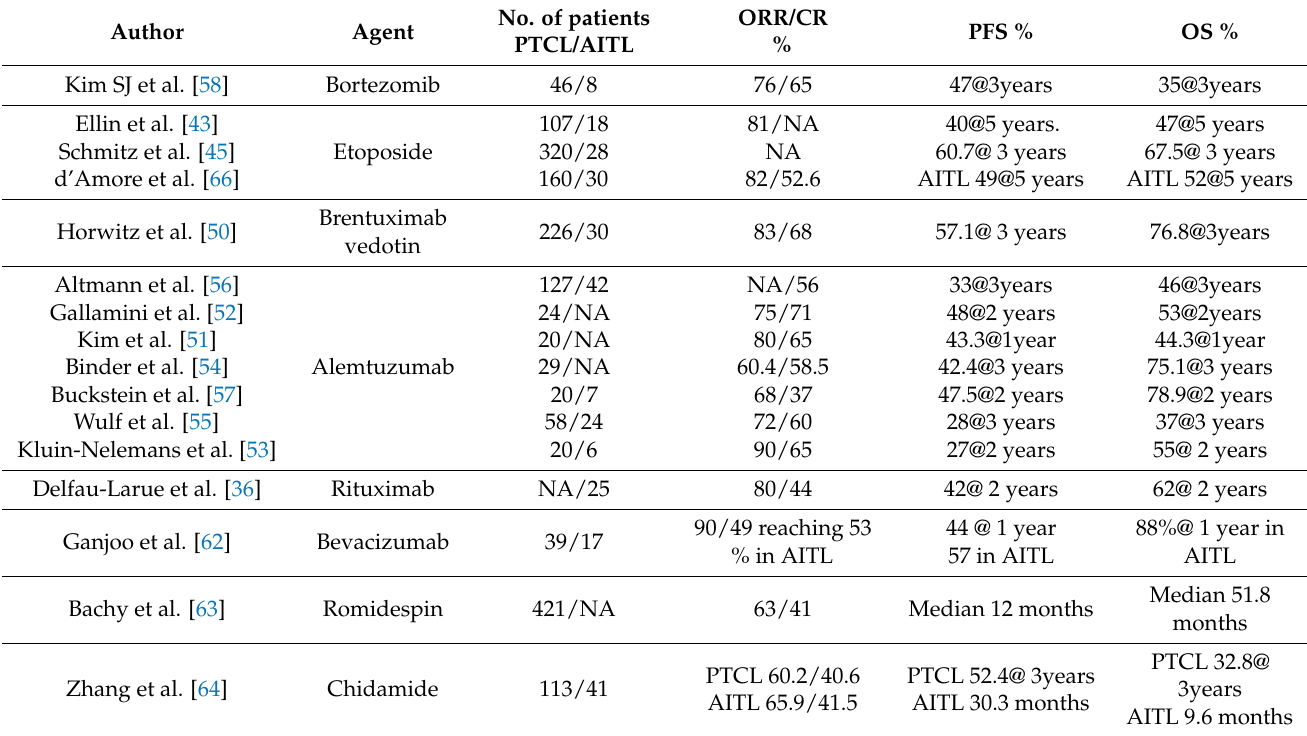
Table 2. Outcomes of additional agents added to CHOP as frontline